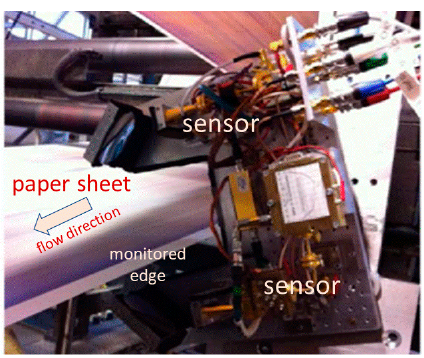
Figure 26. An industrial prototype of an electronic sensor at 200 GHz monitoring paper moisture during offset printing. Adapted from [194].